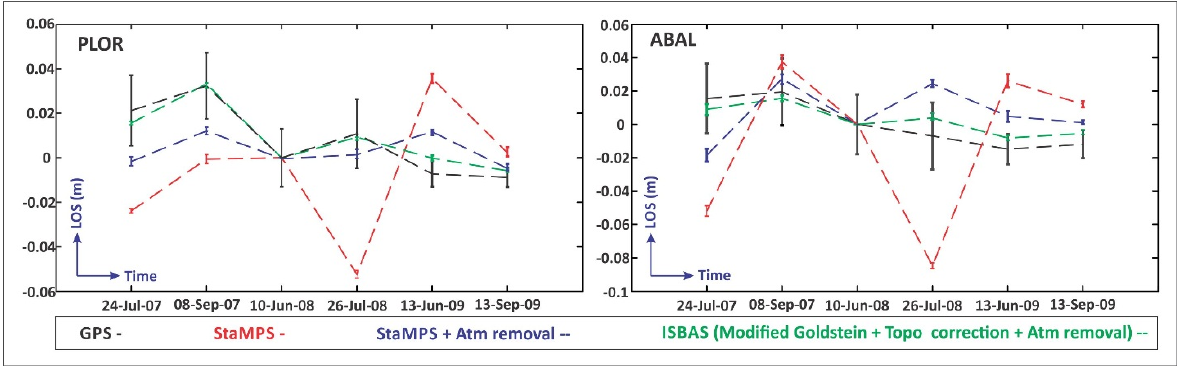
Figure 16. Comparison between GPS-derived LOS displacements and ALOS observations, for PLOR and ABAL